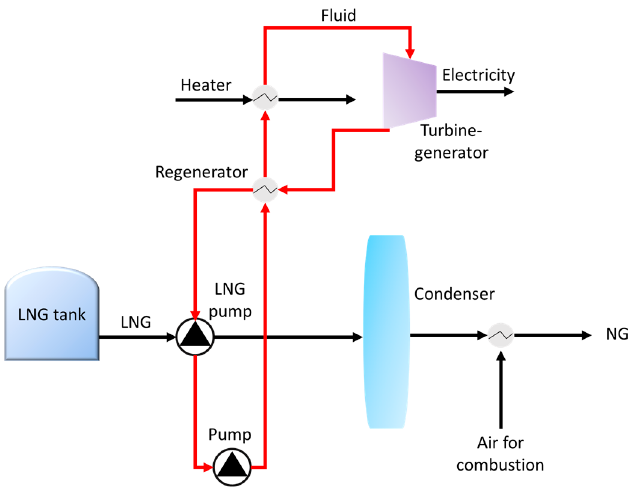
Figure 2. Exploiting LNG cold energy in the Rankine cycle for power generation [39].